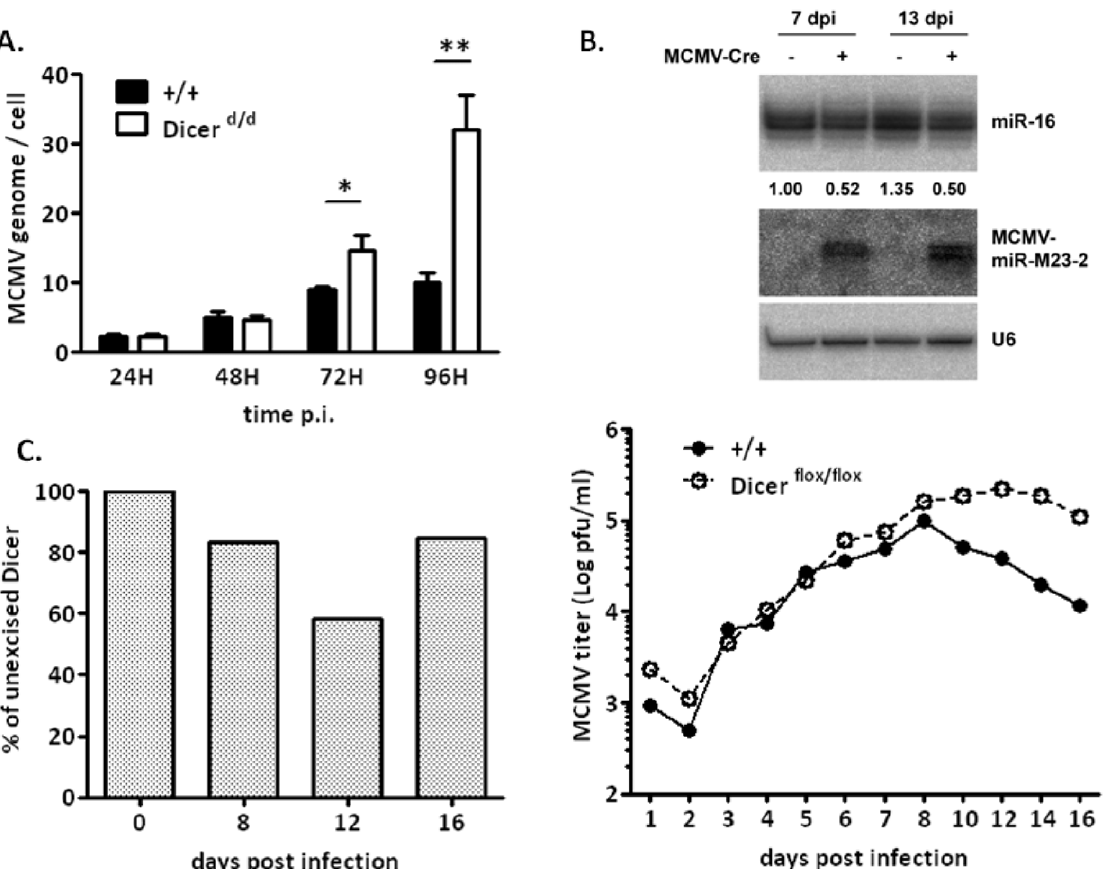
Figure 5. Exvivo infected macrophages harvested from Dicer-deficient mice exhibit antiviral defects. A. Absolute quantification by qPCR of the MCMV genome in control ( + / + , black bars) macrophages and cells isolated from Dicer d/d mice (white bars) at different time points post infection (p.i). B. Northern blot experiments showing, miR-16 and MCMV miR-M23-2 expression in peritoneal macrophages isolated from Dicer flox/flox mice 7 days and 13 days upon MCMV-Cre infection. Numbers below miR-16 panel indicate relative expression. Controls (Ctrl) are